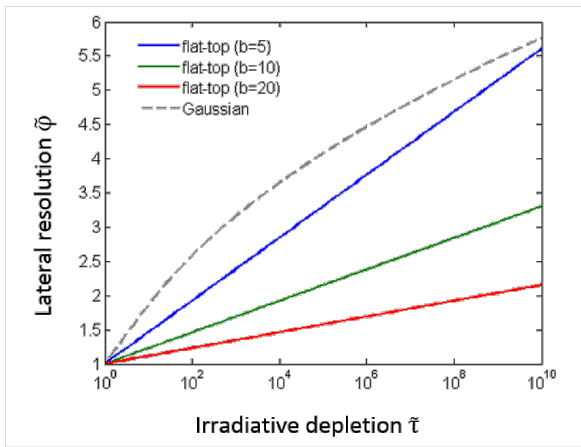
Figure 9: First FEBIP resolution scaling law for Gaussian and tophat electron beams.